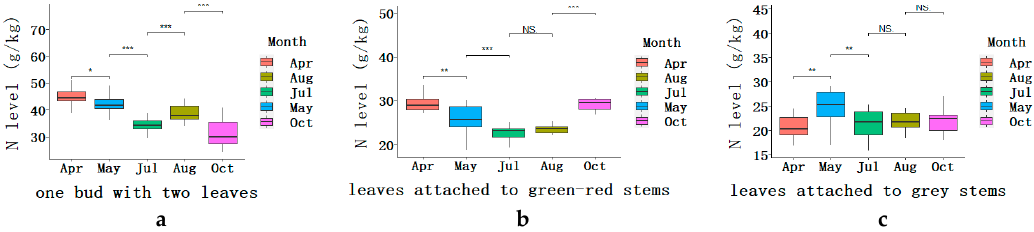
Figure 1. Boxplots for dynamic changes of N level (g N kg − 1 DW) in the three categories of leaves: one bud with two leaves ( a ), leaves attached to green-red stems ( b ), and to grey stems ( c ), during the growing seasons. The values were calculated based on the twenty tea varieties described in Table A1. The box represents the interquartile range (IQR), the bisecting line represents the median, and the whiskers represent 1.5 times the IQR. Asterisks indicate significant differences between averaged N levels of two consecutive rounds, * p < 0.1, ** p < 0.05, *** p < 0.01 ( t -test); NS, not significant. Table 1. Summary for N levels (g kg − 1 ) in the three categories of leaves for the twenty tea varieties over the entire growing seasons.